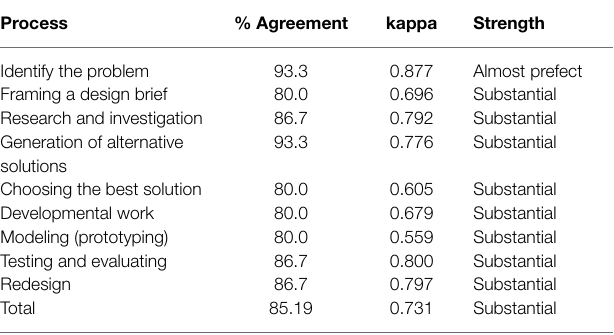
TABLE 2 | Inter-rater reliability of the analysis of EDP in tenth-grade student’s chemistry textbooks and experiment guidebooks.